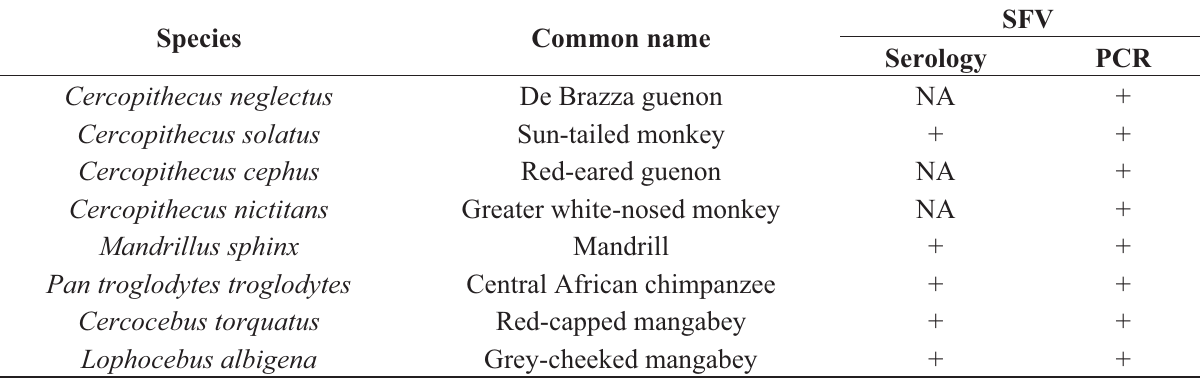
Table 1. The presence of SFV in various species of monkeys and apes collected in Gabon, central